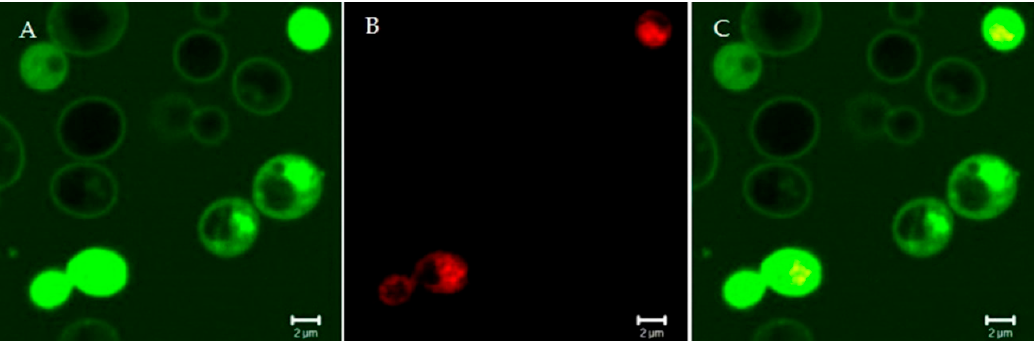
Figure 2. Confocal microscopy images of living Candida albicans cells treated for 15 min with the fluorescein isothiocyanate- labeled Ab gene-peptide L12P ( A ). The peptide was on the yeast cell surface and entered into yeast cells within a few minutes; empty vacuoles were seen. Some yeast cells were no longer viable, as assessed by propidium iodide internalization ( B ). ( C ) merge of panels A and B. Bar: 2 µm. The rapidity of the killing effect suggests a membrane-disrupting mode of action.